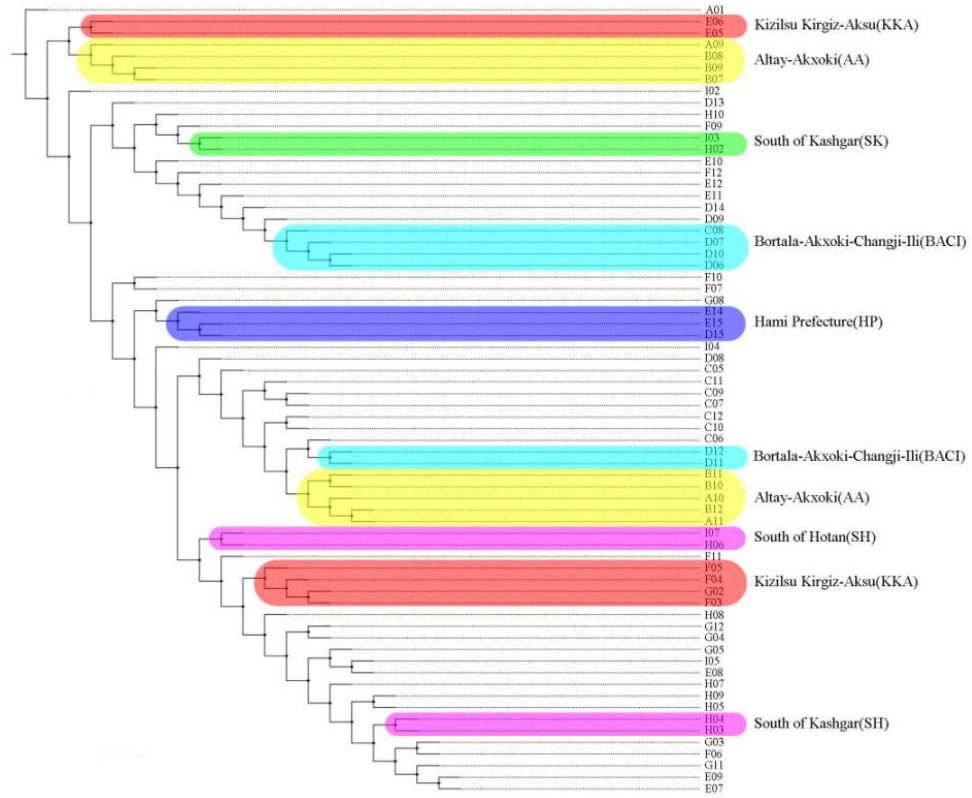
Figure 3. The optimal tree obtained by PAE using TNT v1.5 under a 1.5° grid size. Different coloured shadows represent different AOEs.